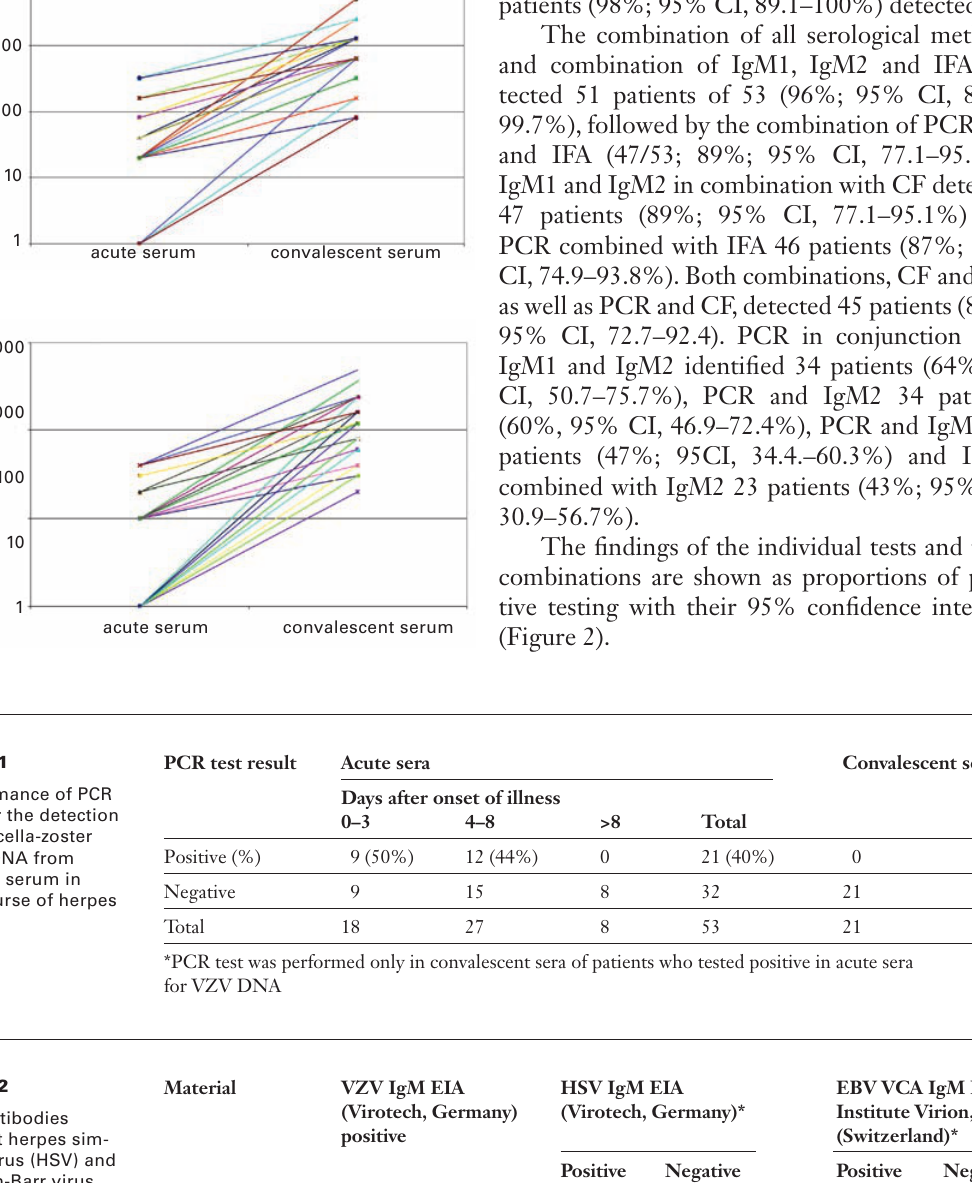
acute serum convalescent serum